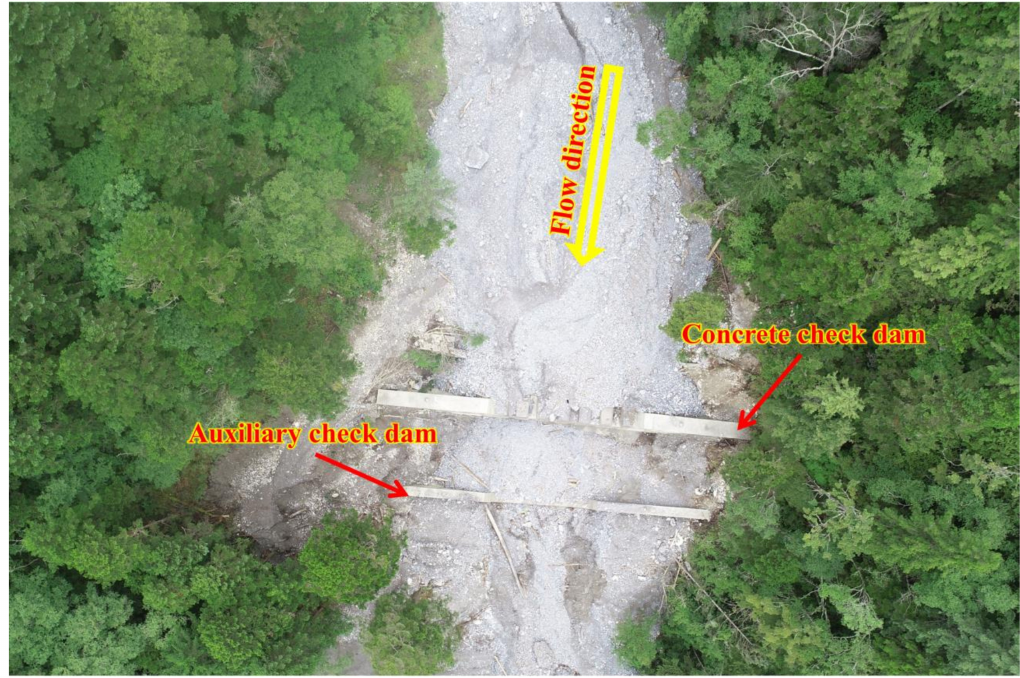
Figure 5. Overview of the reconstructed check dams in Zechawa Gully (taken on 25 June 2019).